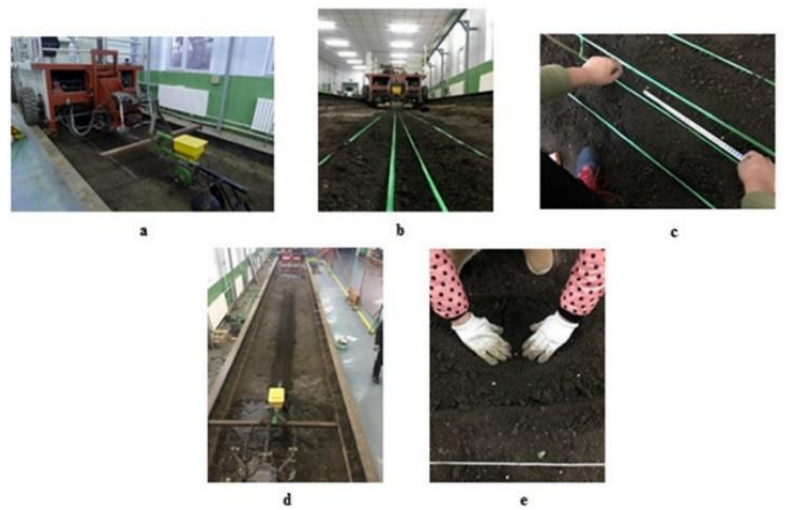
Figure 2. Soil bin test for covering. ( a ) seeding unit with covering discs; ( b ) artificial construction of soil furrow; ( c ) artificial sowing; ( d ) covering soils with precision seeding unit; ( e ) uncovering the seeds by hand.